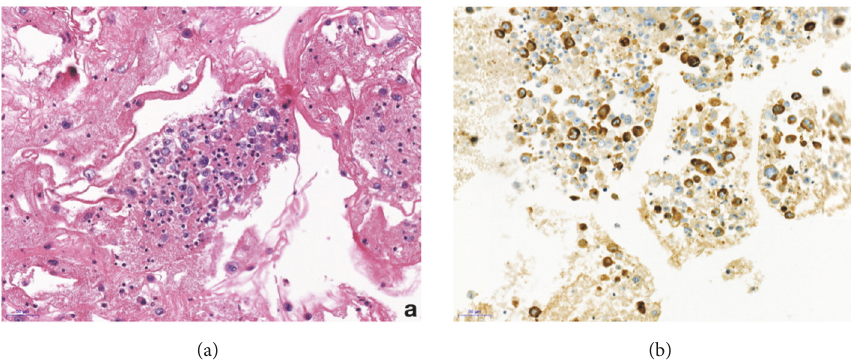
Figure 2: Case 1, representative section of the cell block preparation from effusion fluid. (a) A cluster of lymphoma cells is observed (hematoxylin and eosin); (b) CD30 expression by the neoplastic cells of BIA-ALCL (original magnification 200x).